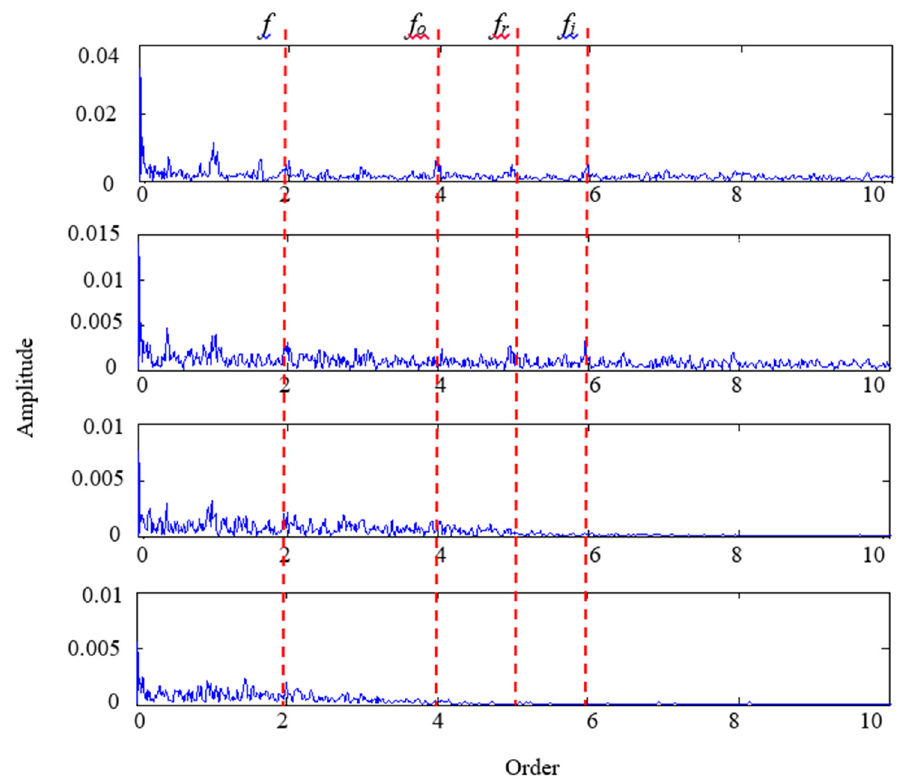
Figure 17. The corresponding spectrums of extracted modes by empirical mode decomposition (EMD). The dashed red line in the figure represents the theoretically calculated fault characteristic order. The waveforms of the four mode envelope spectra are almost the same. The above conditions prove the existence of mode aliasing in